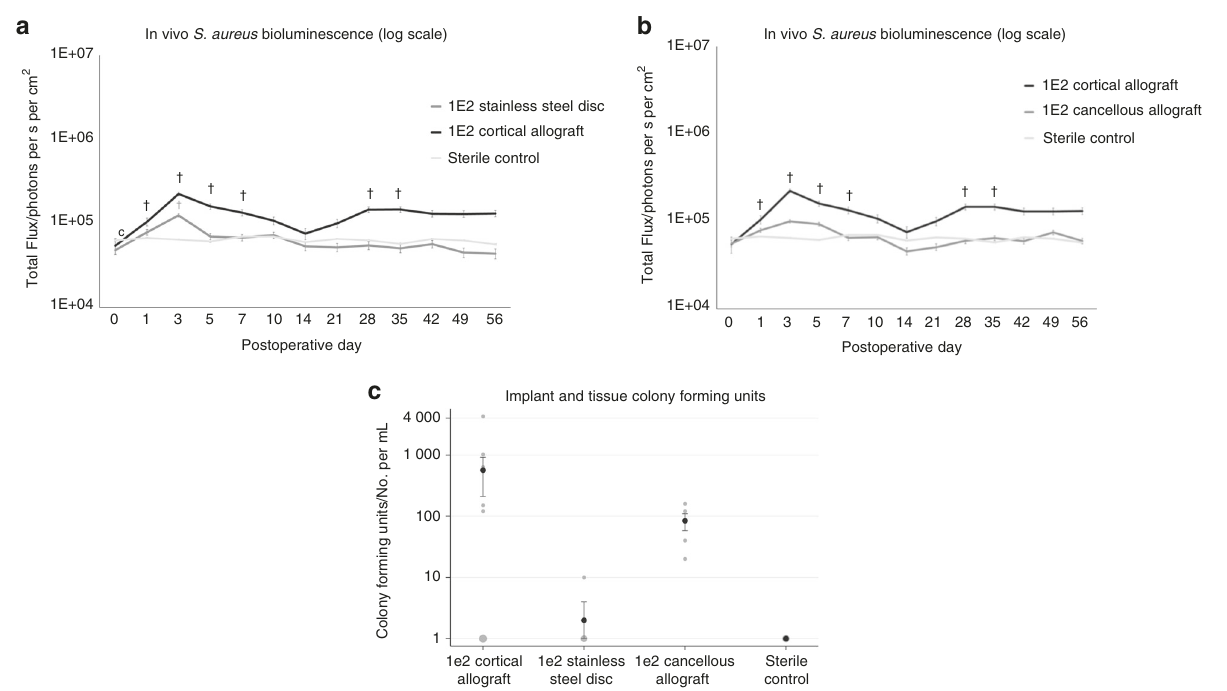
Fig. 2 Quantitative real-time bacterial burden on cortical allograft compared to stainless steel disc or cancellous allograft in a mouse model. a , b Measurement of bacterial burden using in vivo bioluminescence. S . aureus possessing the bioluminescent construct in a stable plasmid (Xen36) in the inoculum 1 × 10 2 CFU or no bacteria as a control were inoculated into the dorsal cervical subcutaneous space of mice in the presence of either a cortical allograft implant vs stainless steel disc ( a ), or cortical allograft implant vs cancellous allograft implant ( b ). Bacterial counts as measured by in vivo S . aureus bioluminescence [total fl ux (photons per s per cm 2 )sem (logarithmic scale)]. Error bars represent standard error of the mean. Full experimental data including 1 × 10 3 CFU inoculum in Supplementary Figs. 3 and 4. † P < 0.05 compared to sterile in the mixed effects regression model using a group-by-time interaction term. c Con fi rmation of bacterial burden using CFU counts. At POD 56 mice were sacri fi ced, implants were sonicated, tissue was homogenized, and bacteria was cultured and counted. Black circles represent mean. Error bars represent standard error of the mean. Gray plot points represent individual data points, and size of plot point circle is proportional to number of data points at that value. The number of bacterial CFU that were adherent to the implant and in the surrounding tissue was determined by counting CFU after overnight culture of plates, and was expressed as CFUs per mL